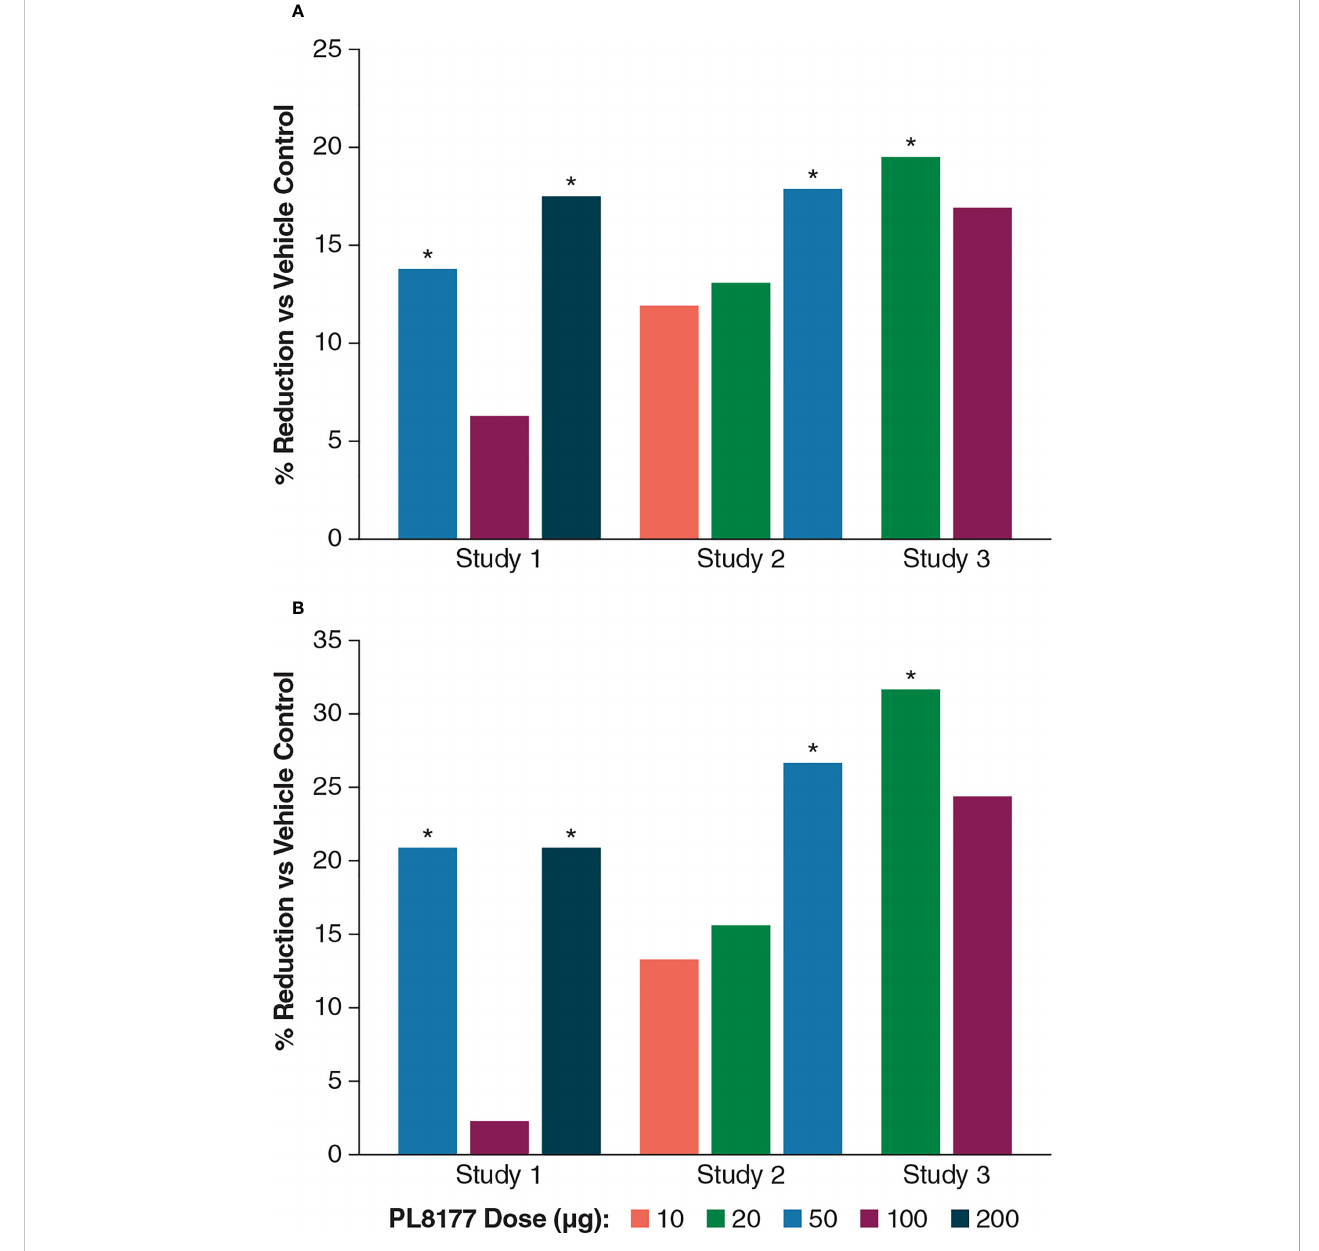
FIGURE 2 Percentage differences from vehicle across PL8177 doses in DNBS colitis – induced rats: (A) macroscopic damage score and (B) ulcer/in fl ammatory score. * P <0.05, treated vs vehicle control; 1-way ANOVA followed by Dunnett ’ s test. ANOVA, analysis of variance; DNBS, 2,4-dinitrobenzene sulfonic